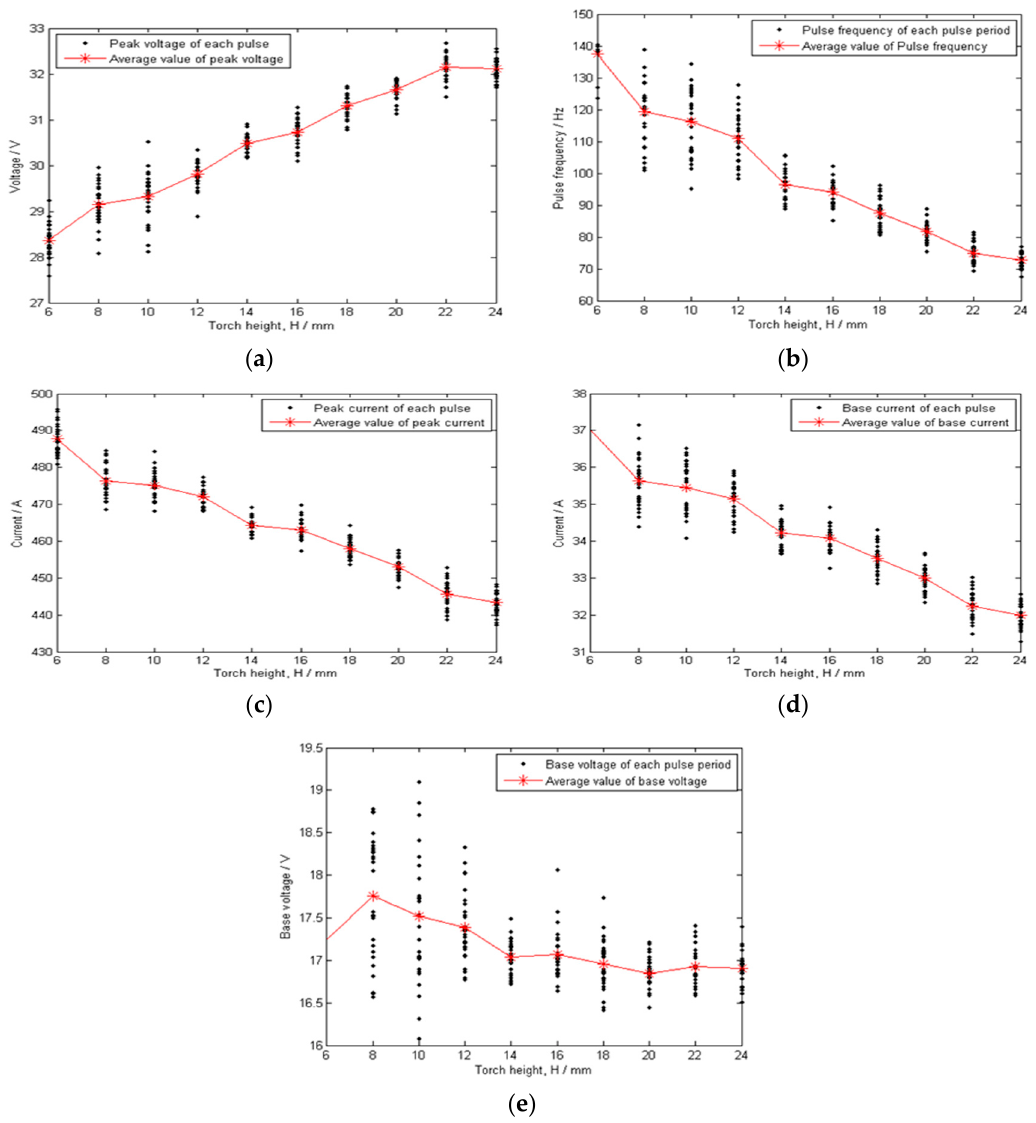
Figure 13. Arc signal characteristics for different torch heights: ( a ) Pulse voltage; ( b ) Pulse frequency; ( c ) Pulse current; ( d ) Base current; ( e ) Base voltage.